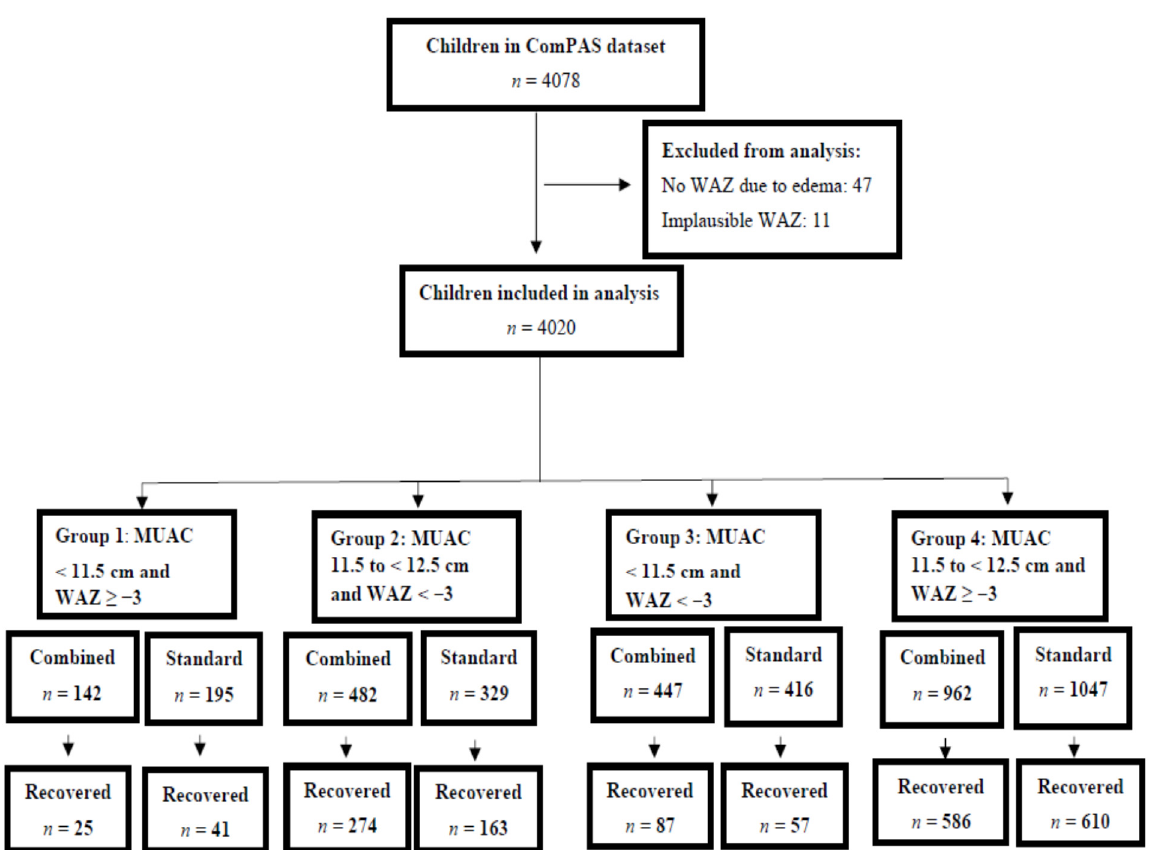
Figure 1. Analysis flow chart. MUAC, mid-upper arm circumference; WAZ, weight-for-age z-score.